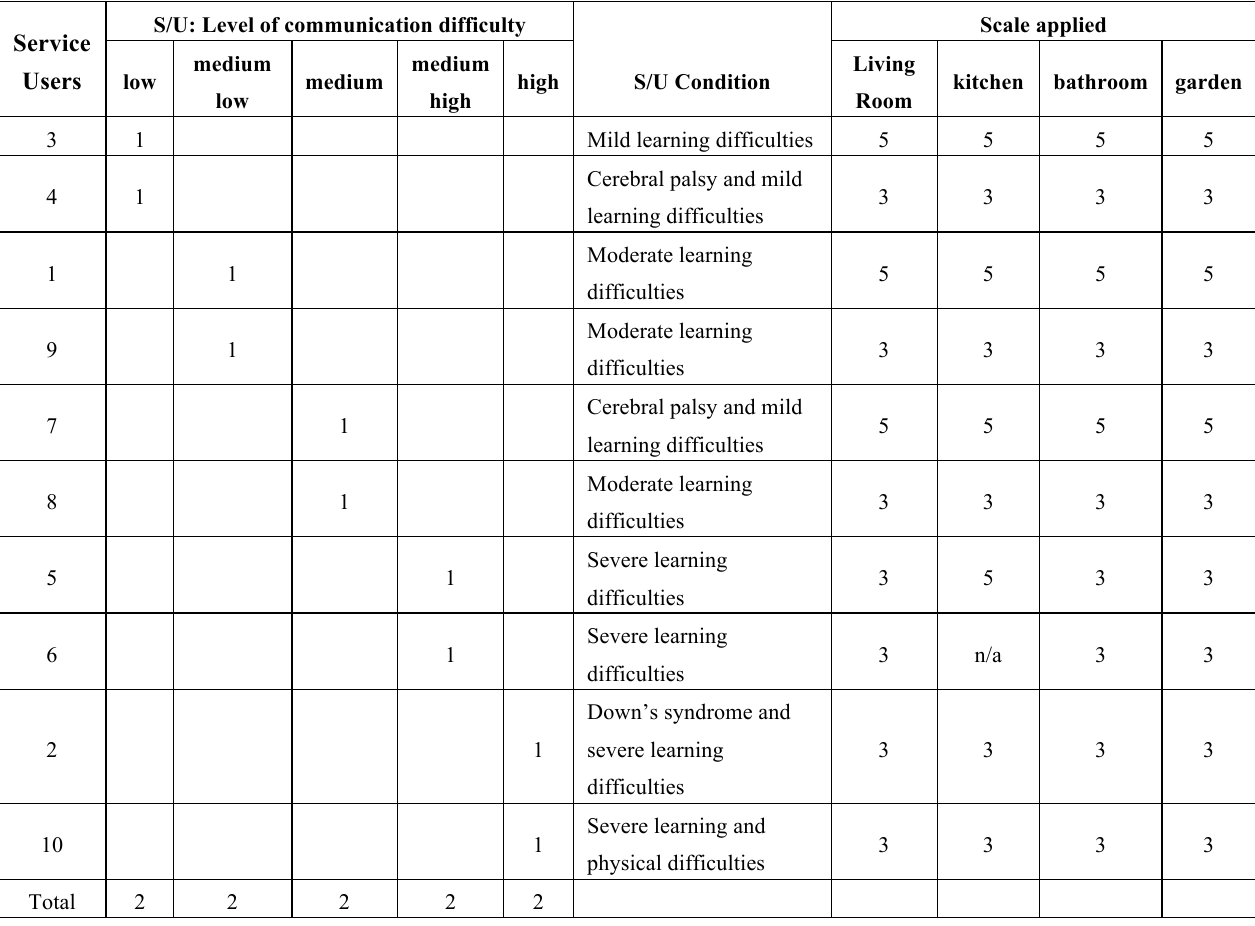
Table 2. Participants used for new knowledge production